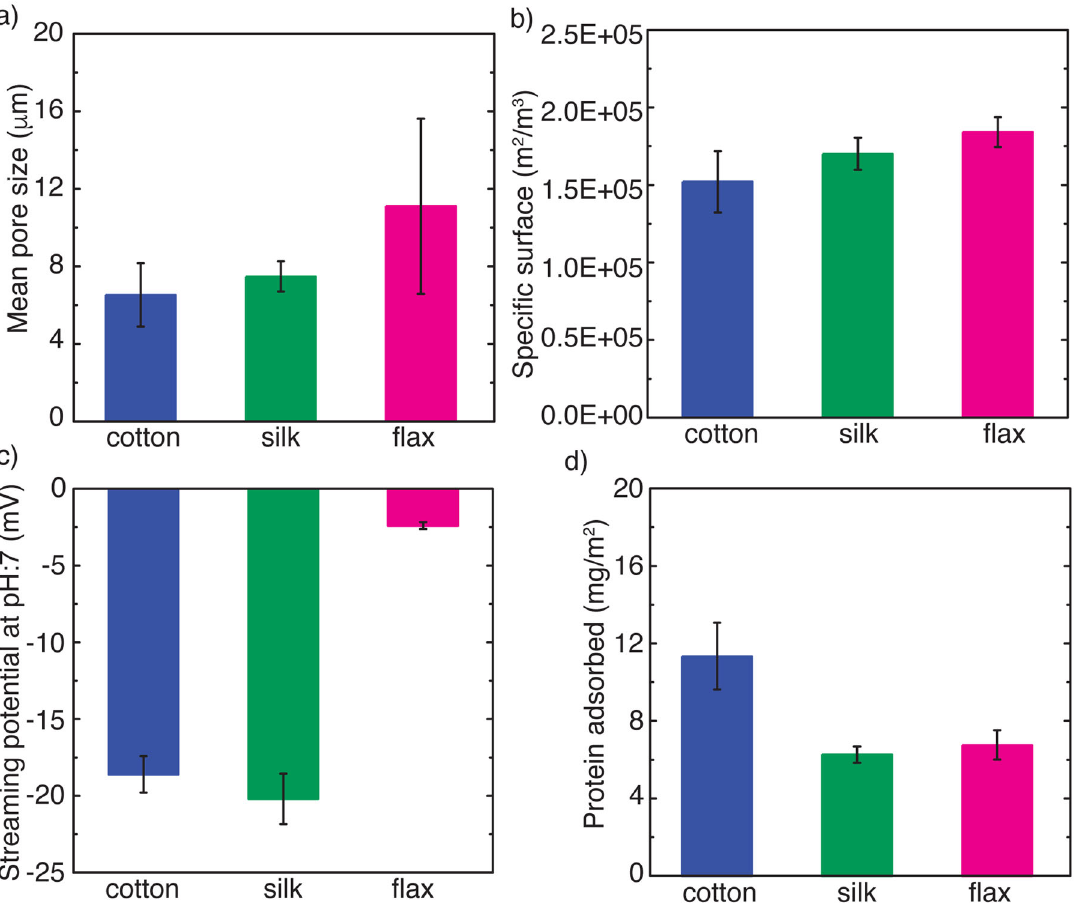
Fig. 3 Standard characterization shows that cotton, fl ax, and silk fi bers can be packed into microporous depth fi lters that can be easily functionalized with MO water extract. a The mean pore size of fi ber fi lters was measured using a capillary fl ow porometer with water as a wetting liquid. The results show that cotton, silk, and fl ax fi ber fi lters exhibit a mean pore size of 6.54 ± 1.64 µm, 7.48 ± 0.78 µm, and 11.1 ± 4.51 µm, respectively. b The speci fi c surface area estimated using BET adsorption analysis showed that cotton, silk, and fl ax fi lters offer similar high surface fi lters for MO functionalization. c The streaming potential measurements of uncoated natural fi bers indicate that they are negatively charged ( − 2.4 ± 0.23 mV to − 20.2 ± 1.64 mV at pH: 7) favoring the adsorption of MO cationic proteins. The streaming potential measurements in the pH range of 5 to 8 are shown in Supplementary Fig. 2. d Quanti fi cation of MO protein adsorbed on the surface of natural fi ber fi lters desorbed using 600 mM NaCl solution shows that cotton has the highest protein adsorption capacity. All the error bars shown in the fi gure represent the standard deviation calculated from three independent